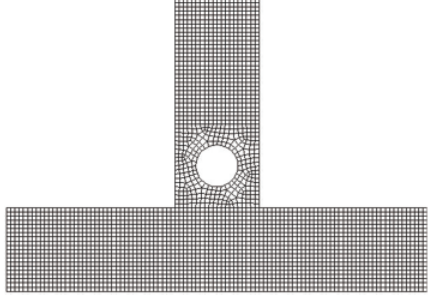
Figure 2: The mesh used in numerical